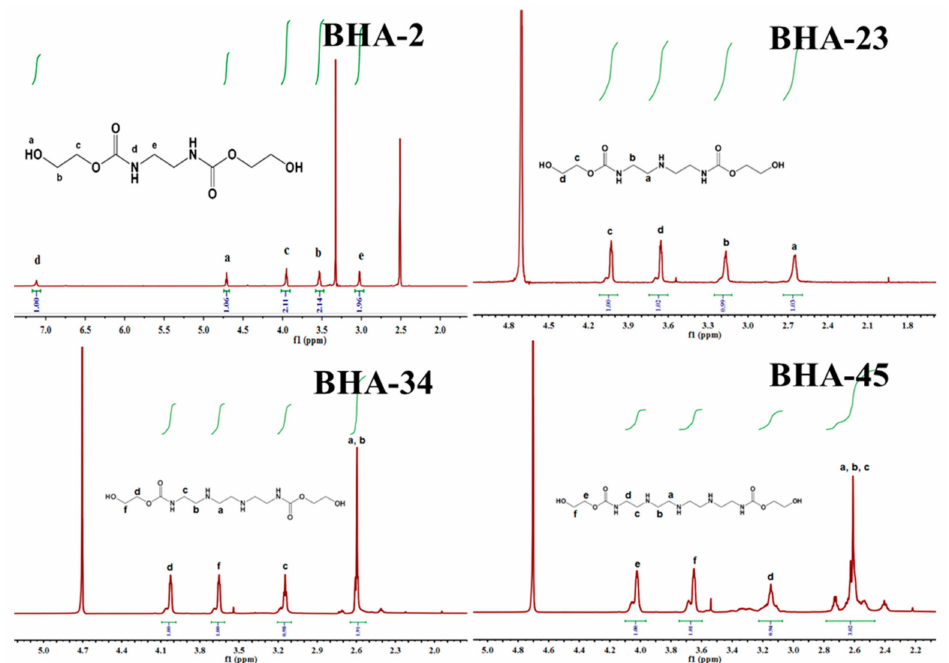
Figure 1. 1 H nuclear magnetic resonance (NMR) spectra of four BHAs. ( BHA-2 ) 1 H NMR (DMSO- d 6 ):